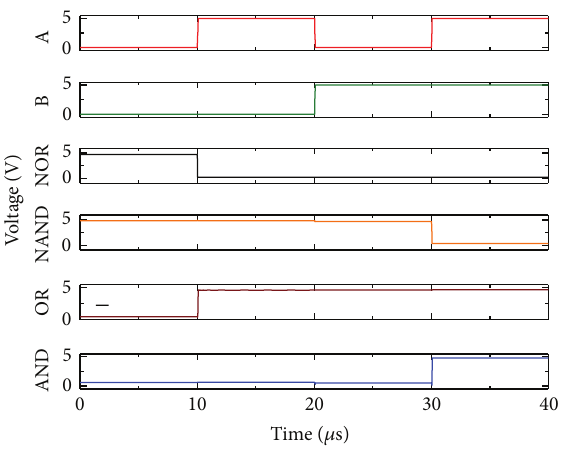
Figure5:Operationofnc-SiTFT-basedlogicgates:(a)and(b)show input waveforms, and (c)–(f) show the outputs of OR, AND, NOR, and NAND gates, respectively.